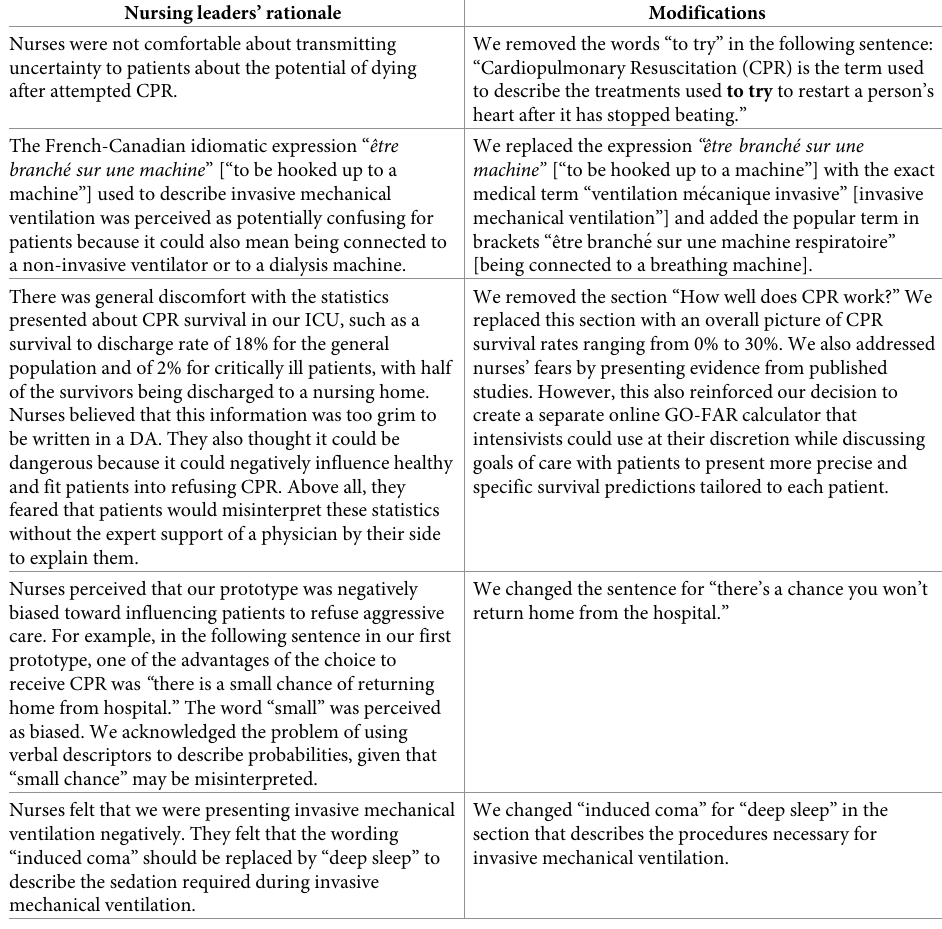
Table 2. Modifications to the prototype following comments by nurse leaders. Nursing leaders’